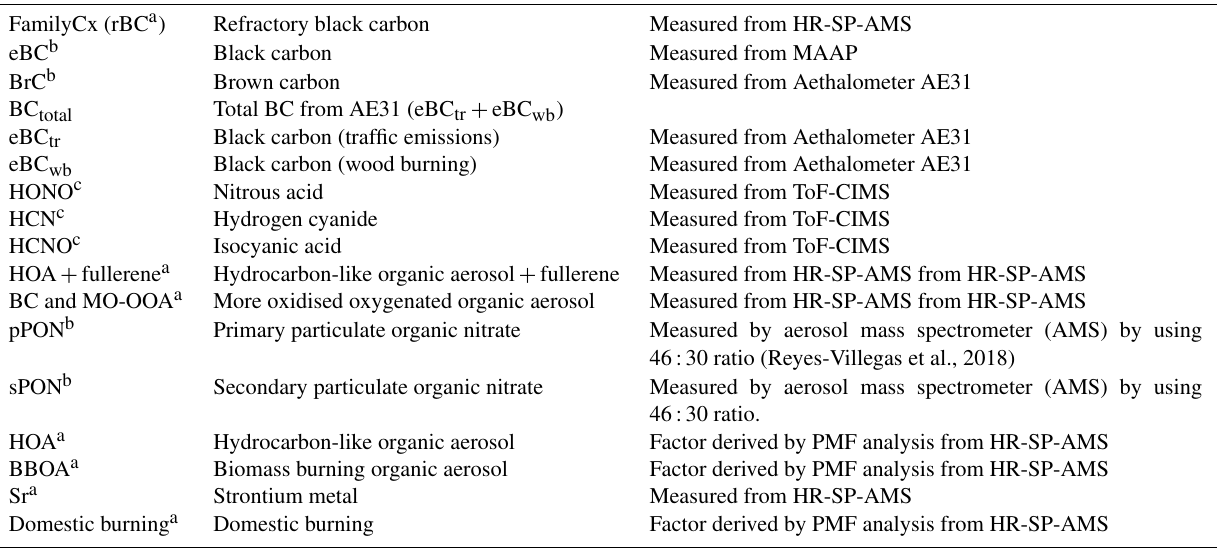
Table 1. Explanation of the time series used in Figs. 4 and